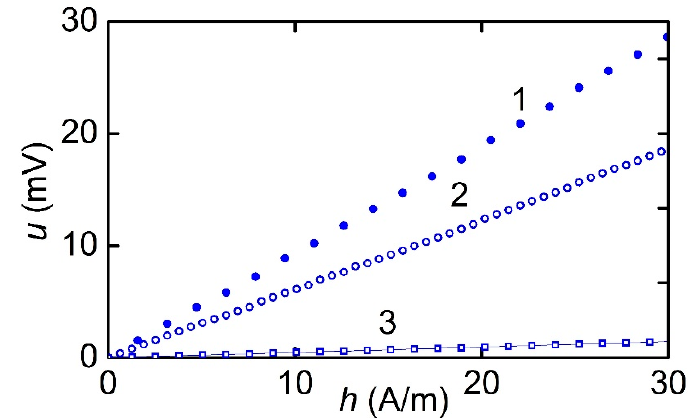
Figure 8. Dependence of the М E voltage u on the excitation field amplitude h for various MFC-PE structures: 1- T 1 = 250 µ m, magnetized along the wires; 2- T 2 = 500 µ m, magnetized along the wires; and 3- T 1 = 250 µ m, magnetized across the wires.